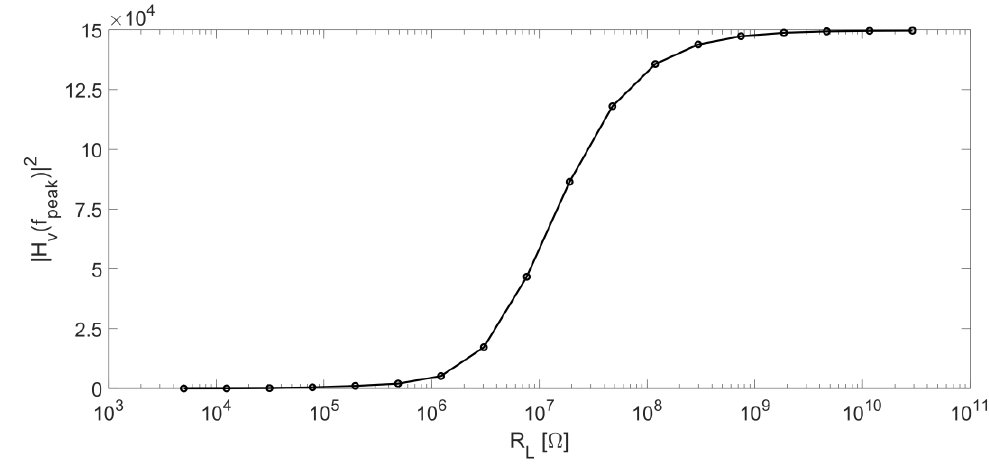
Figure 7. Peak value of |H v | 2 as a function of R L.